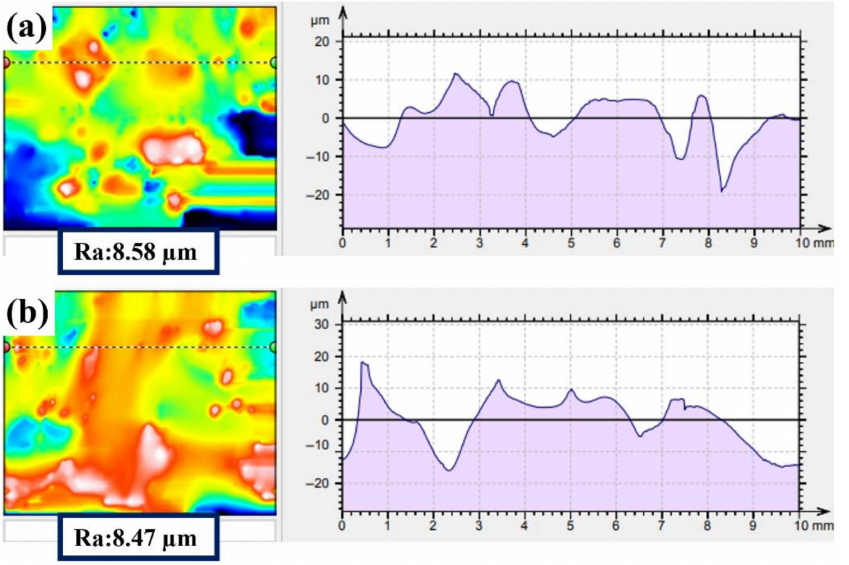
Figure 2. 3D white light diagram for ( a ) NAP and ( b ) AP